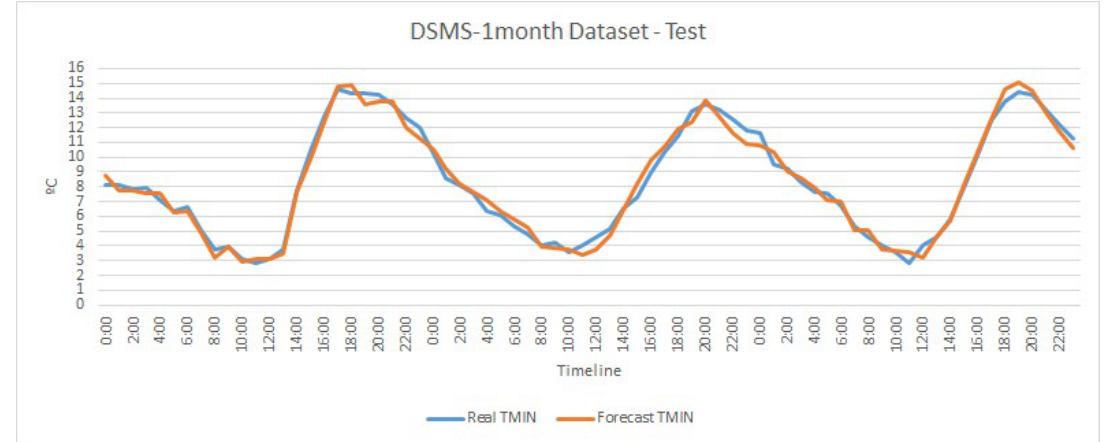
Figure 5. Graphical representation of the actual and predicted minimum temperature values under testing by the multivariate LSTM model for the dataset